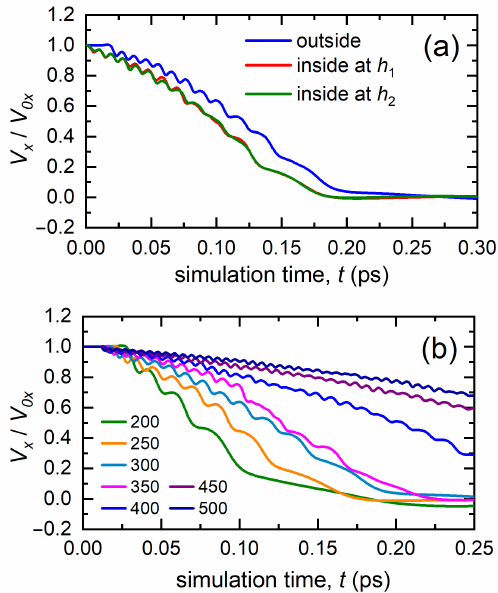
Figure 2. The x -component of the velocity of the bombarding atom as a function of simulation time. The velocity is normalized to its initial value V 0 x . ( a ) The case of different initial positions of the bombarding atom launched with the initial velocity of 300 Å/ps. The blue line corresponds to the case when the atom is located outside the crystal at the distance of h = 6.94 Å from the free surface (marked as ‘outside’ in the legend for Figure 2a). The red and green lines correspond to the initial position of the atom inside the crystal at the depth of h 1 = 8.542 Å (marked as ‘inside at h 1 ’ in the legend) and h 2 = 23.841 Å (marked as ‘inside at h 2 ’). In all cases, the atom starts at the axis of the octahedral channel. ( b ) The case of different initial velocities of the bombarding atom, excited according to scenario two, case